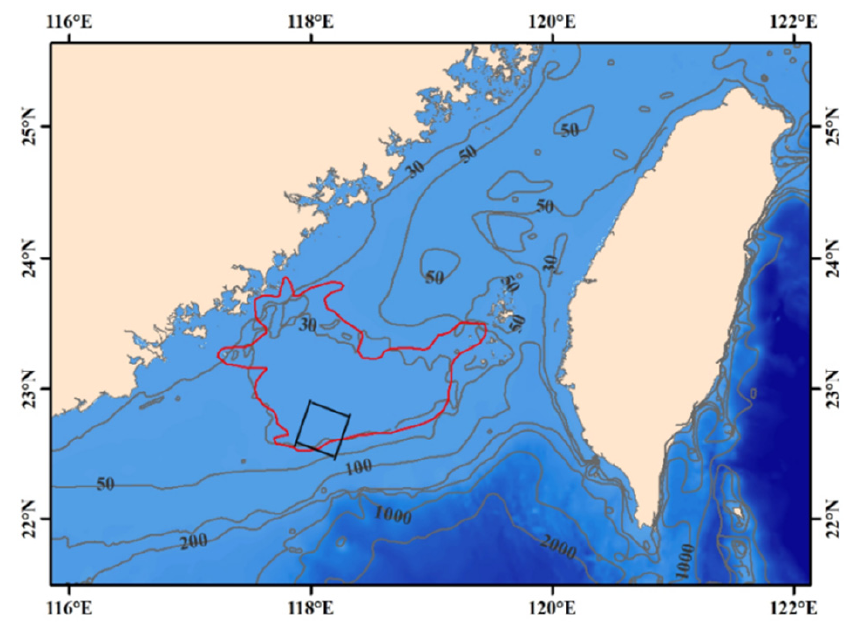
Figure 1. Taiwan Strait shallow sand wave topography in full view. The red boundary indicates the outer envelope range of the shallow Taiwan Strait with an area of ~16,400 km 2 , and the black box indicates the remote sensing image range as in Figure 2 with an area of ~3600 km 2